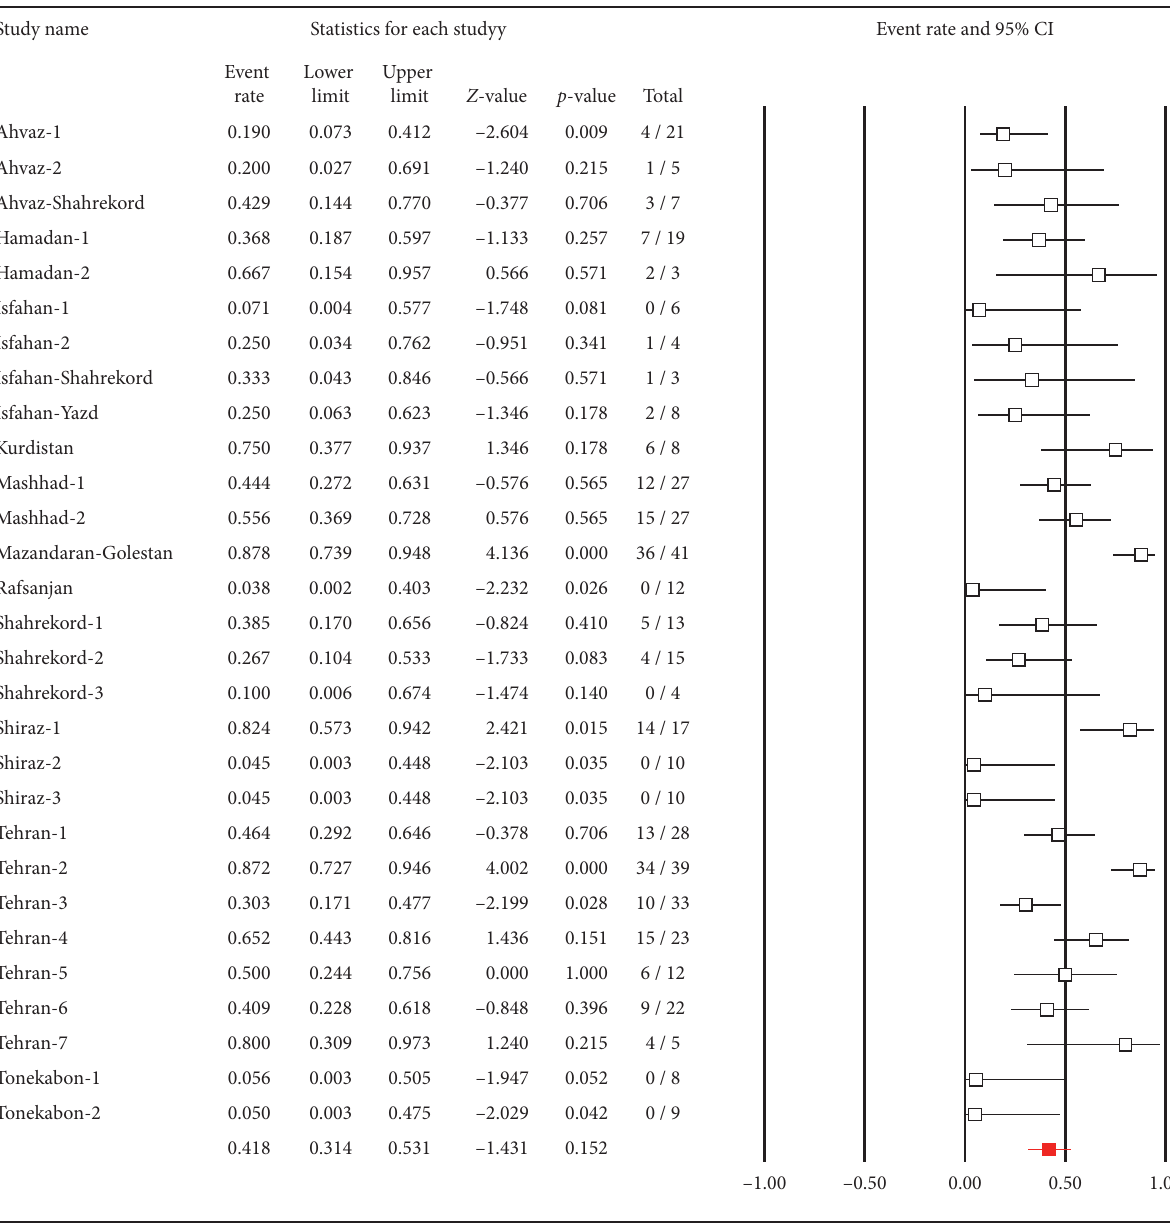
Figure 4: Forest plot of the meta-analysis of the prevalence of C. jejuni resistant to ciprofloxacin in